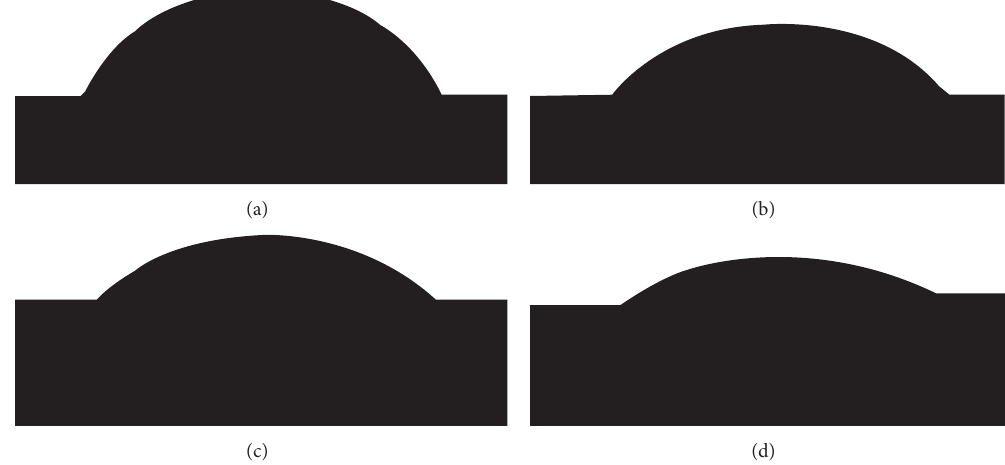
Figure 5: The change in the contact angles of membranes containing different blends of PLDLA/PCL-T: (a) 100/0, (b) 90/10, (c) 70/30, and (d) 50/50.